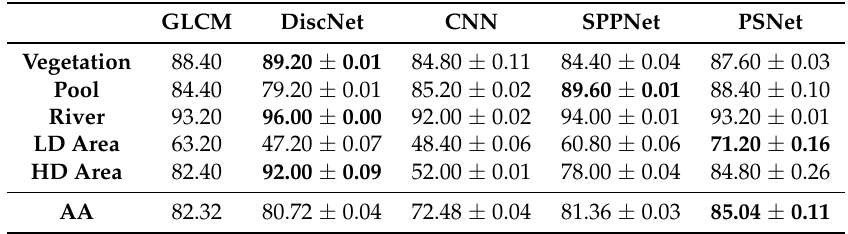
Table 4. Classification accuracy (%) on the Guangdong dataset. The bold number highlights the greatest classification accuracy per row.